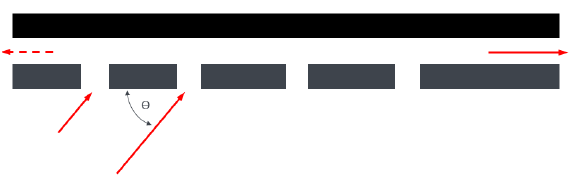
Figure 6. Schematic of the coupling from OCCWG cross section to the fundamental mode waveguide behind the mirror surface. The waveguide depth is matched for the single hole contributions to coherently add up.